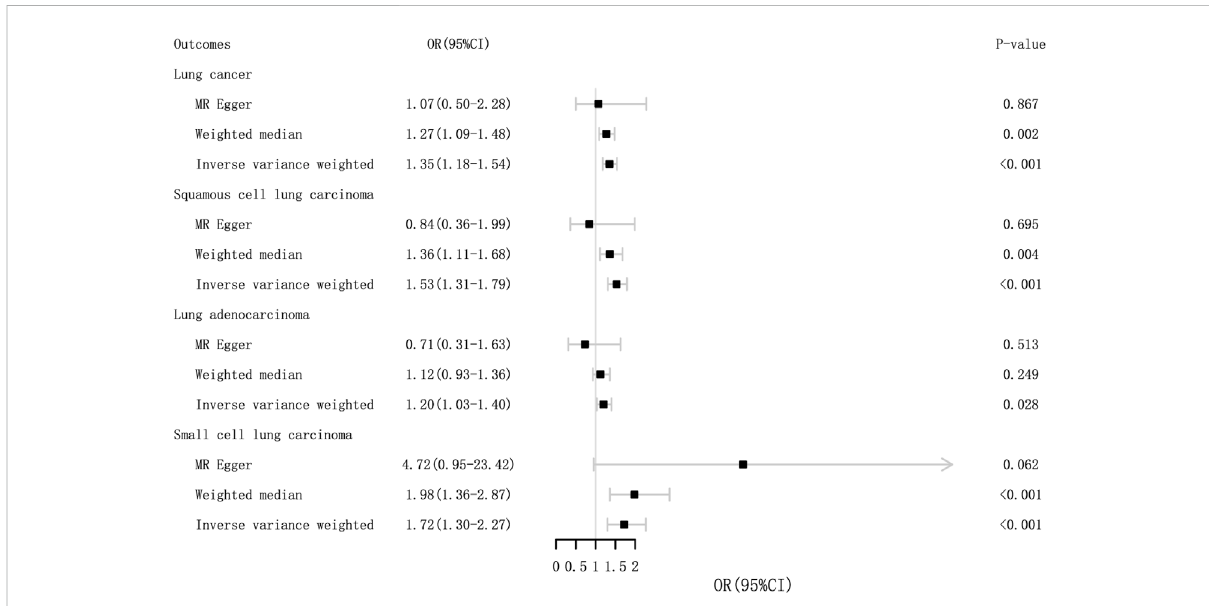
FIGURE 3 Odds ratios and p -value of MR analysis for the associations between GERD and lung cancer in the EBI. OR, odds ratio; 95% CI, 95% con fi dence